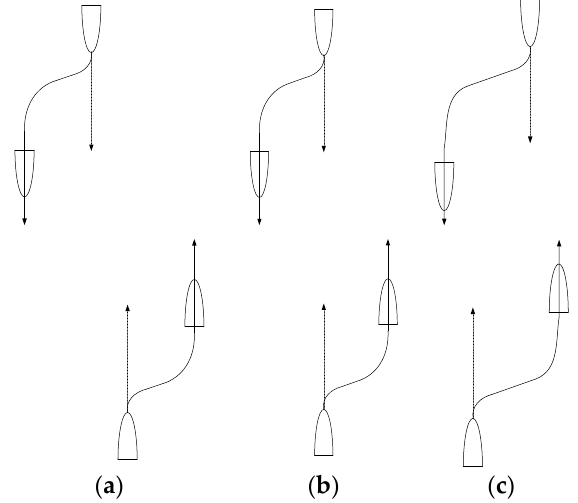
Figure 2. The illustration of a head-on situation ( a ) port-to-port encounter, ( b ) meeting on reciprocal courses, and ( c ) right-to-right encounter.